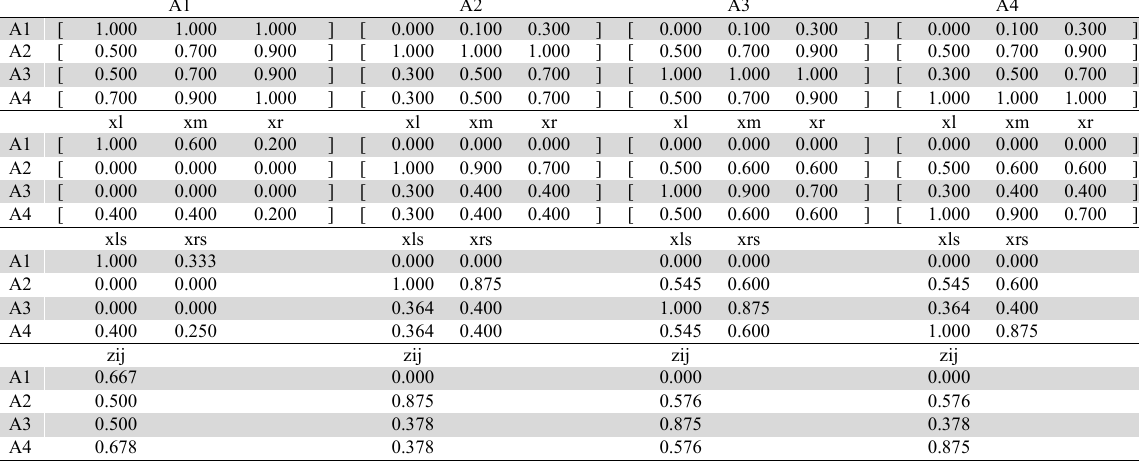
Defuzzification procedure from experts